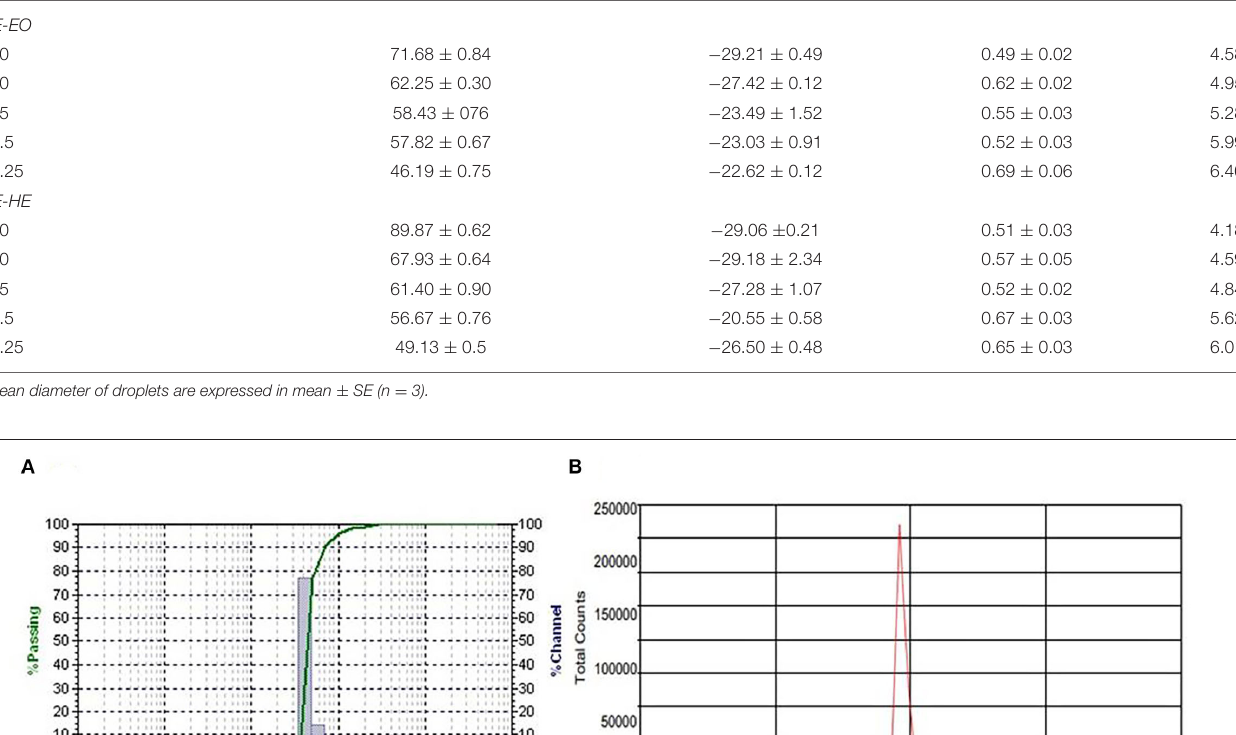
TABLE 2 | Physico-chemical characterizations of NEs loaded with EO and HE of P. cablin leaves. Concentrations ( µ g mL − 1 )